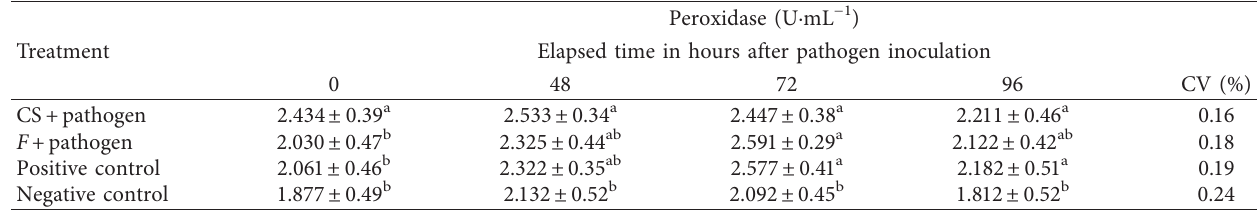
Table 3: Average peroxidase (POX) activity in guarana leaves.